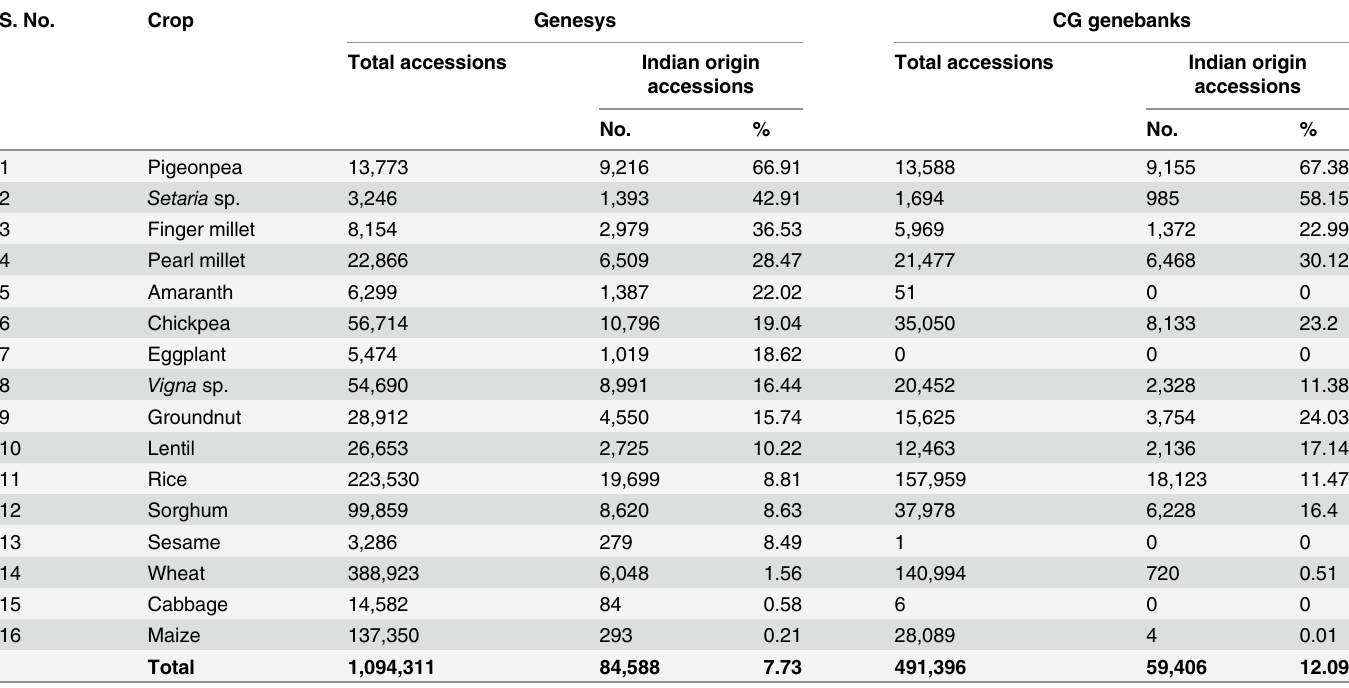
The table lists the details of 16 crops having the maximum representation in the Genesys portal. The crops are arranged in the decreasing order of percentage of Indian origin accessions in the total accessions list of Genesys Portal. Indian-origin accessions have been also derived separately for total accessions conserved by CG genebanks, from the same